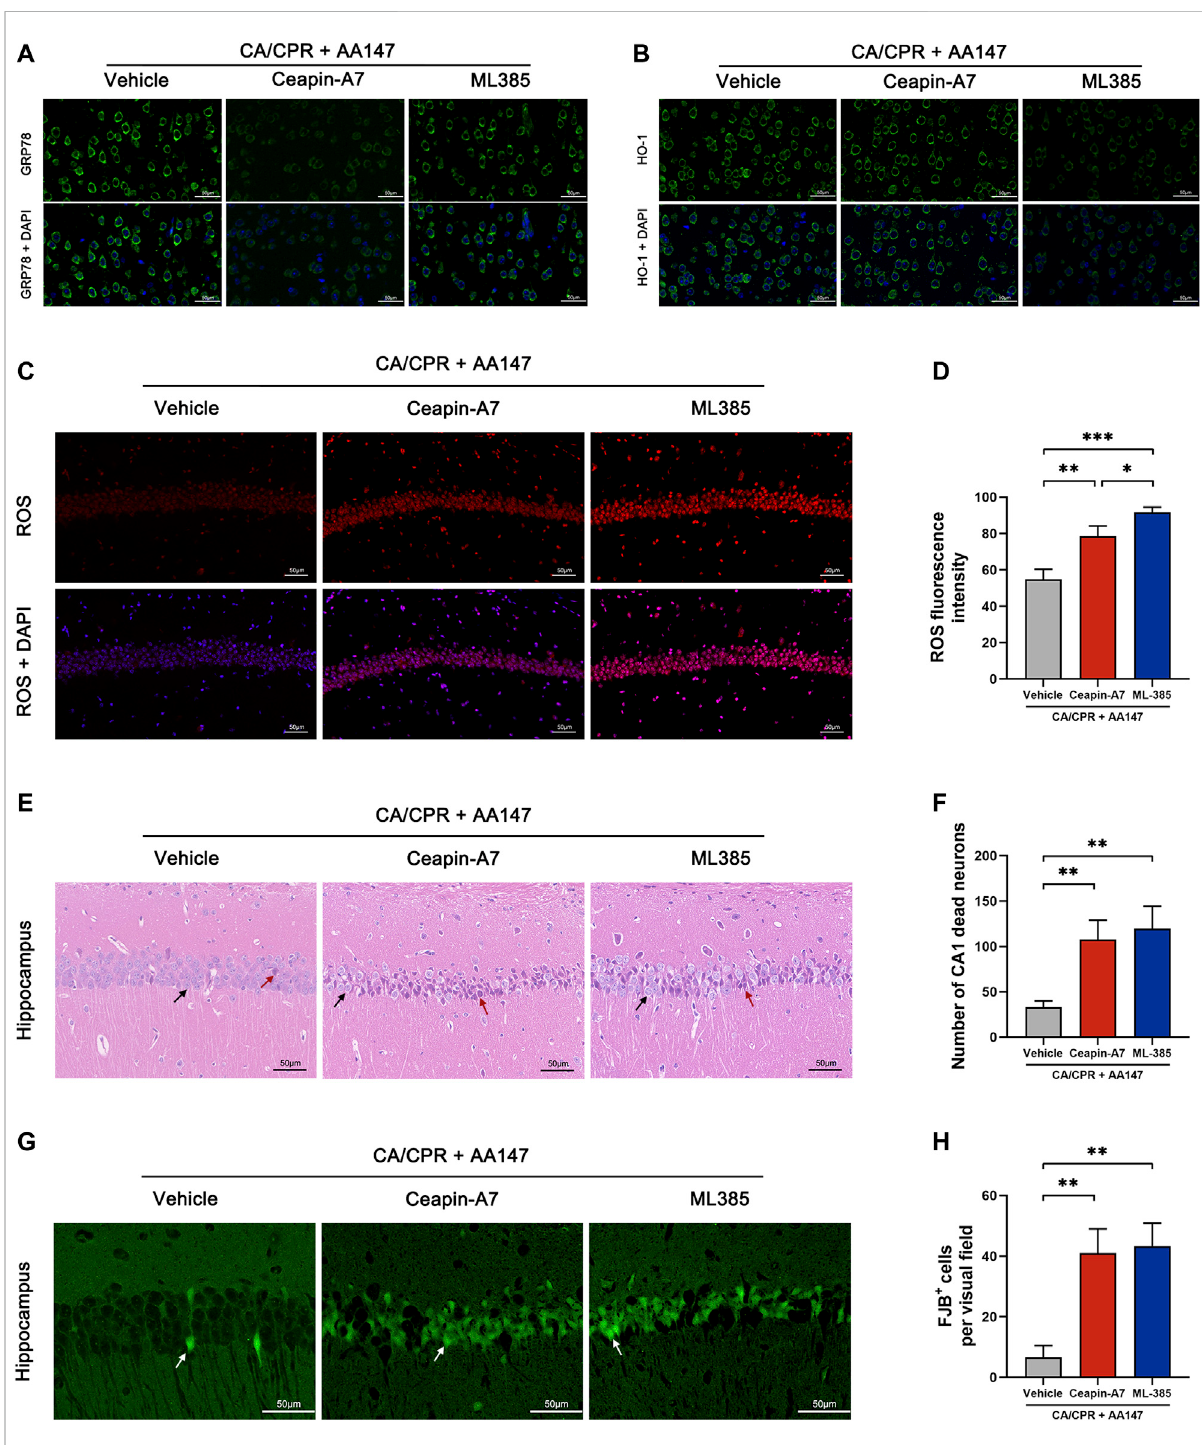
FIGURE 7 ProtectiveeffectofAA147againstpost-cardiacarrestcerebralischemia/reperfusioninjurywasabolishedbytheATF6inhibitorCeapin-A7orthe Nrf2 inhibitor ML385. Ceapin-A7 or ML385 were administered to mice 2 h before the administration of AA147. The brain tissue samples were collected for immuno fl uorescent staining and ROS detection at 1 day after CA/CPR and for evaluation of neuronal death at 3 days after CA/CPR. (A) Representative images ofimmuno fl uorescentimagesofGRP78showed that Ceapin-A7 decreasedAA147-induced increase in ATF6-regulated geneGRP78expression. (B)